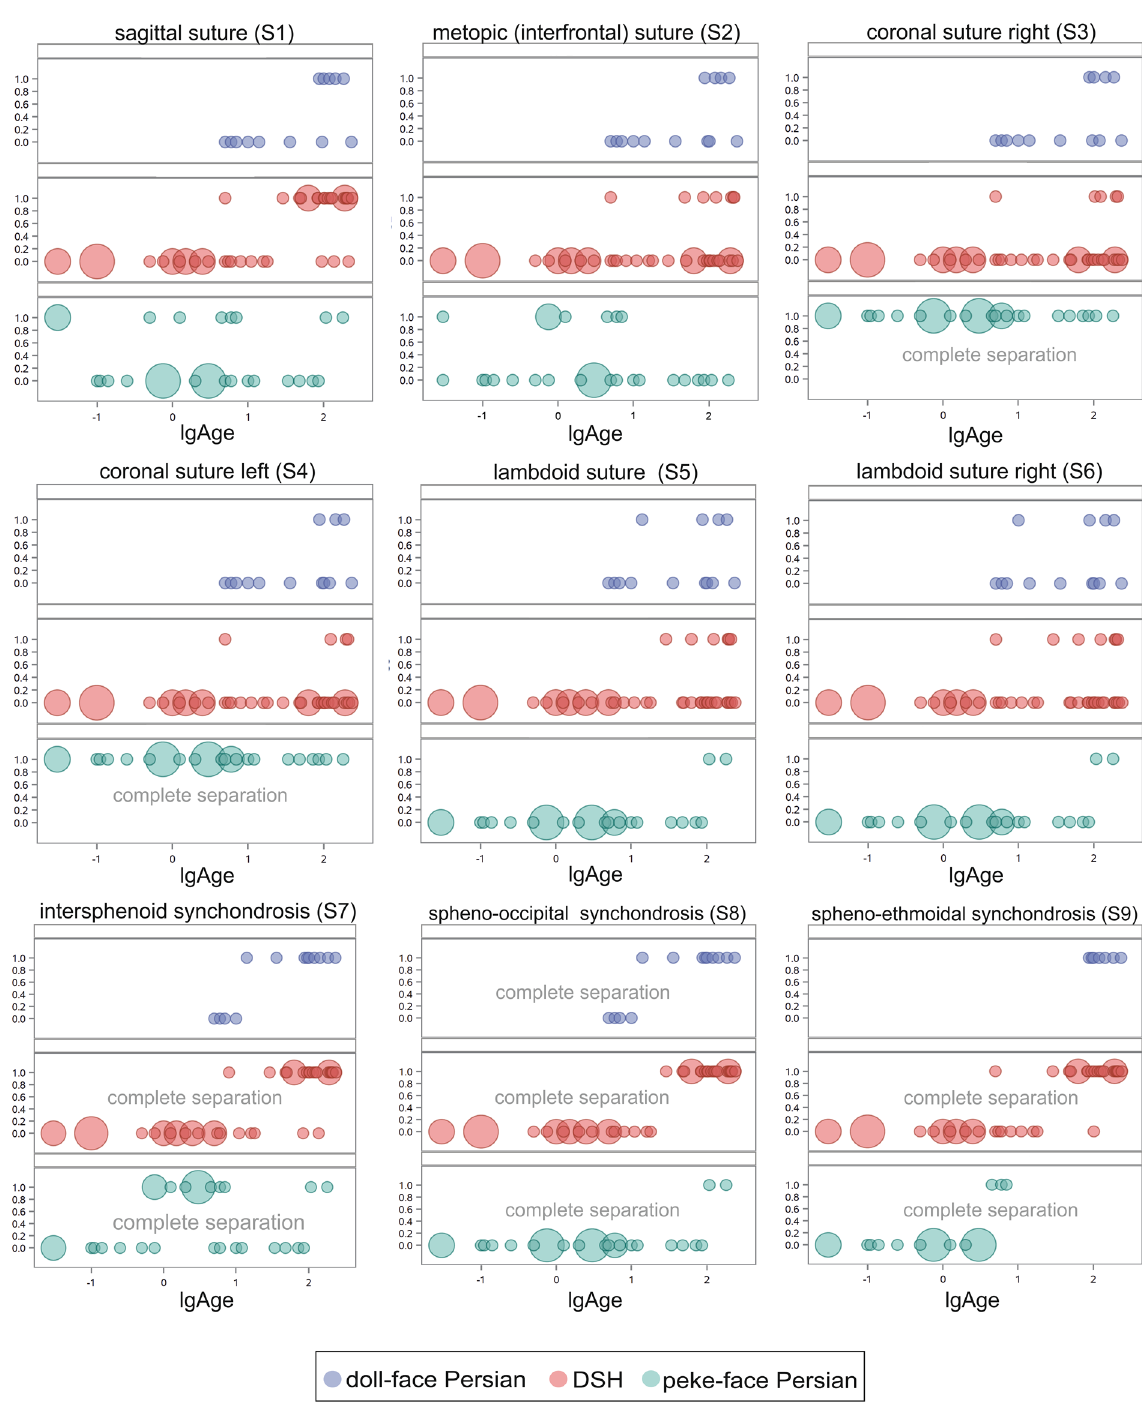
Figure 7. Scatter plot of the open and closed status of the examined sutures and synchondroses in the different groups depending on age. Domestic Shorthair cats indicated in red circles, doll-face Persians in blue and peke- face Persians in green circles. Circle sizes indicate number of